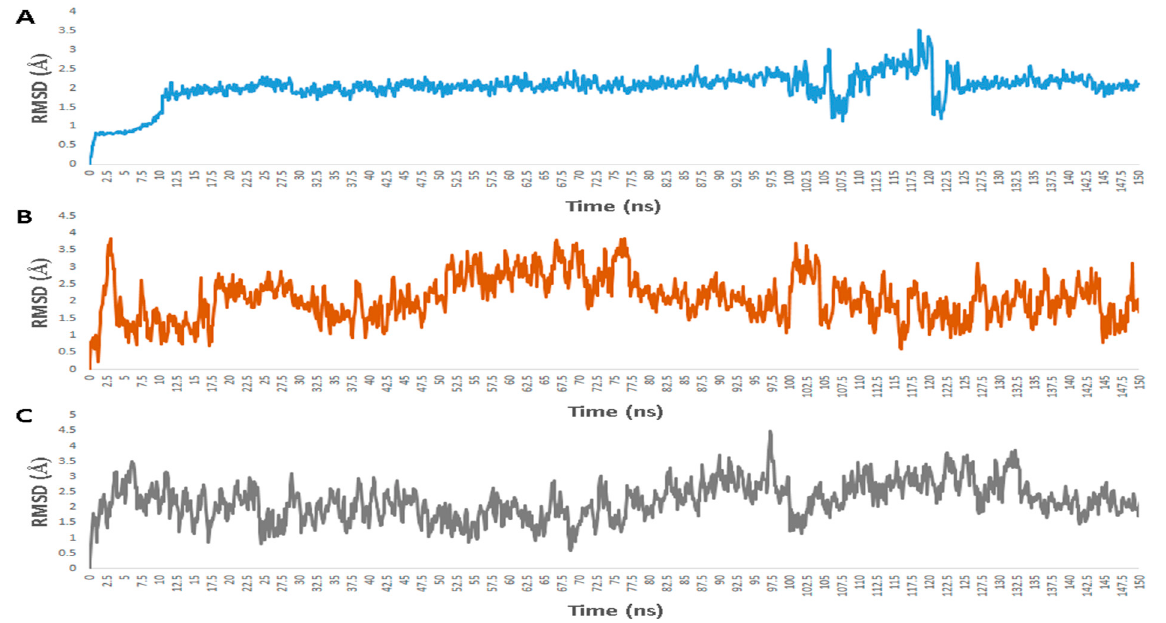
Figure 7. RMSDs of cnicin inside the binding sites of the viral proteins: ( A ) nsp3 (ADPRP), ( B ) nsp12 (RdRP), and ( C ) nsp15.